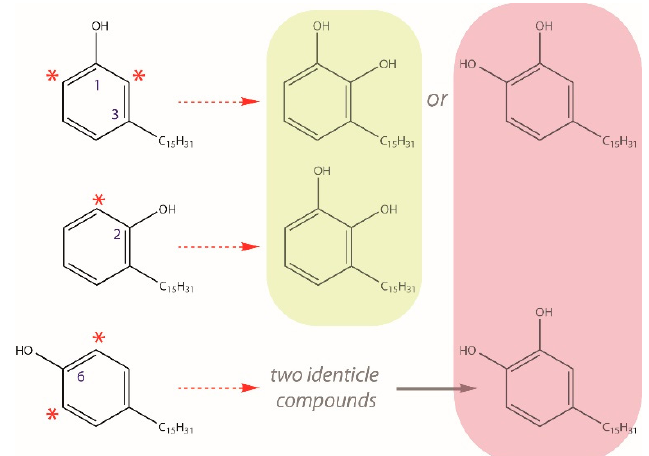
Figure 8. Potential C15:0-cardanol isomer substrates and putative cardanol hydroxylase urushiol reaction products (shaded). Numbers indicate harmonized aromatic carbon positions relative to a stated 3-pentadecyl alkane chain. Red asterisks indicate hydroxyl-proximal aromatic carbon atoms that would be preferentially hydroxylated by a proposed cardanol hydroxylase enzyme activity (red arrows). Proposed urushiol isomers are indicated by different shaded boxes.